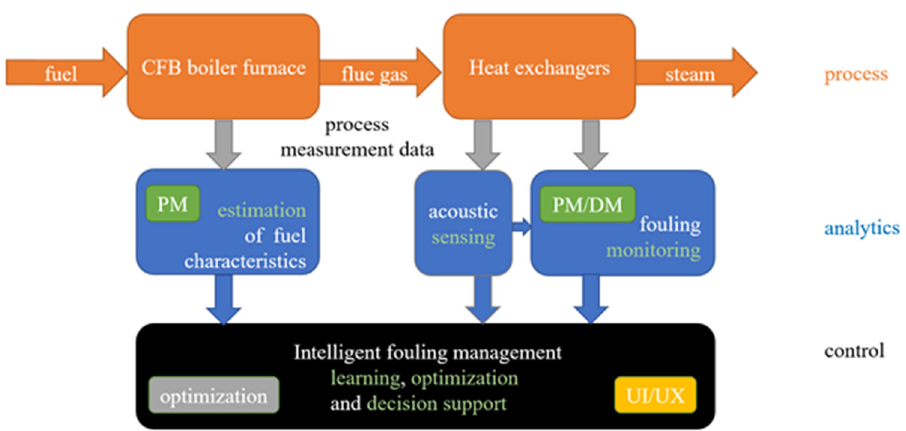
Figure 7: Intelligent fouling management. PM stands for physics - based modeling, DM for data - driven modeling, and UI/UX for user